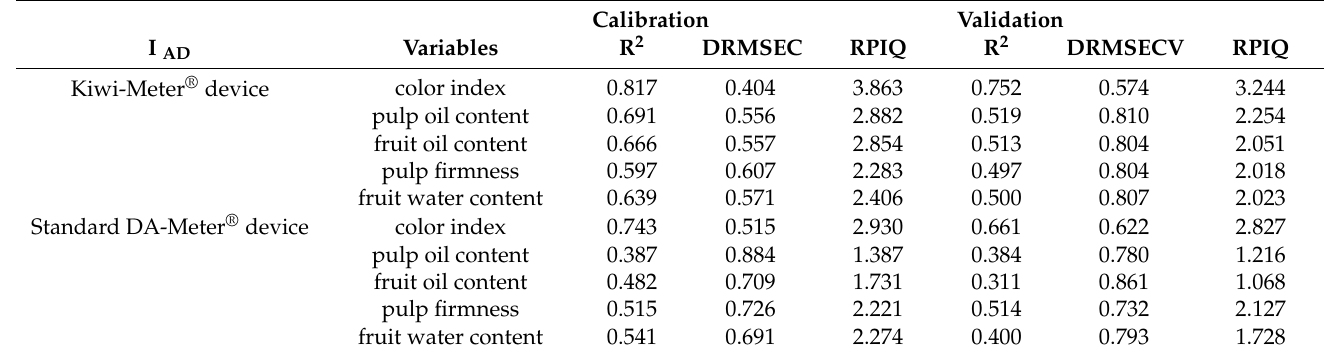
Figure 2. ( A ) Relationship between color index and I AD . ( B ) Relationship between pulp oil content and I AD . ( C ) Relationship of fruit water content and I AD . ( D ) Relationship between pulp firmness and I AD by Standard DA-Meter ® device. The solid black line represents the regression line and the upper and the lower lines represent the prediction intervals. Regression equation is reported on the top of each graph. Table 3. Calibration and validation indexes of the linear regression